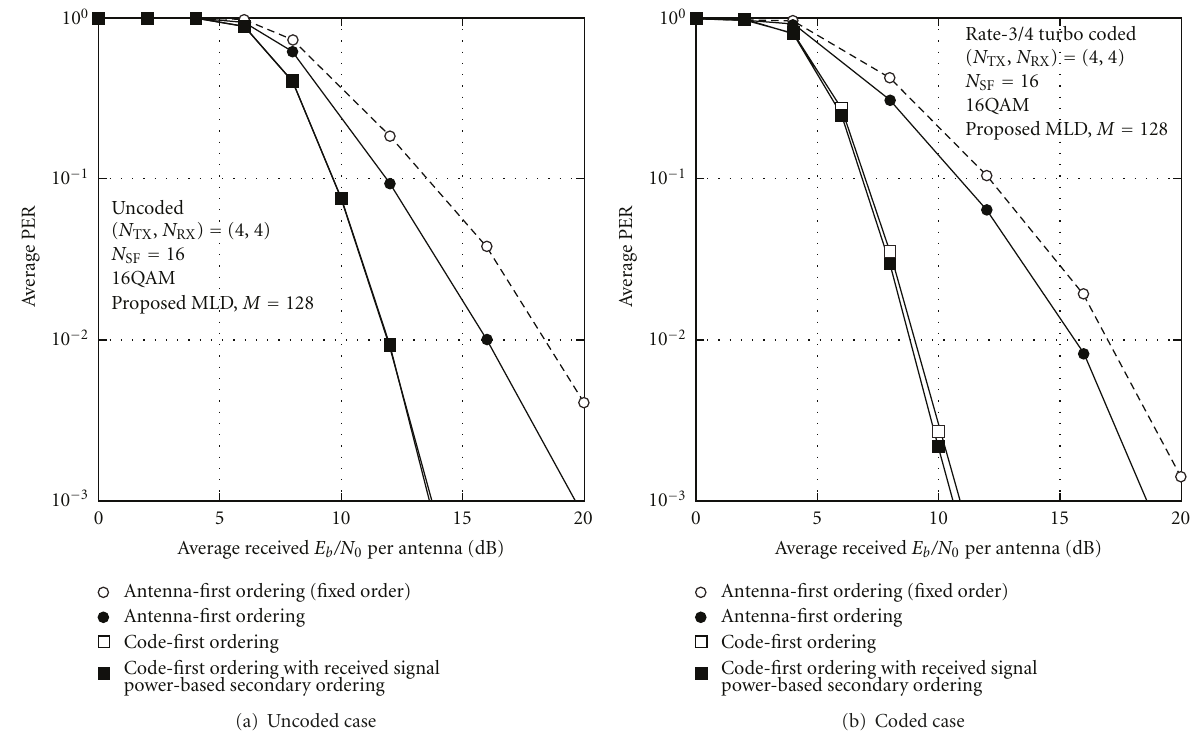
Figure 4: Comparison of symbol ordering methods.